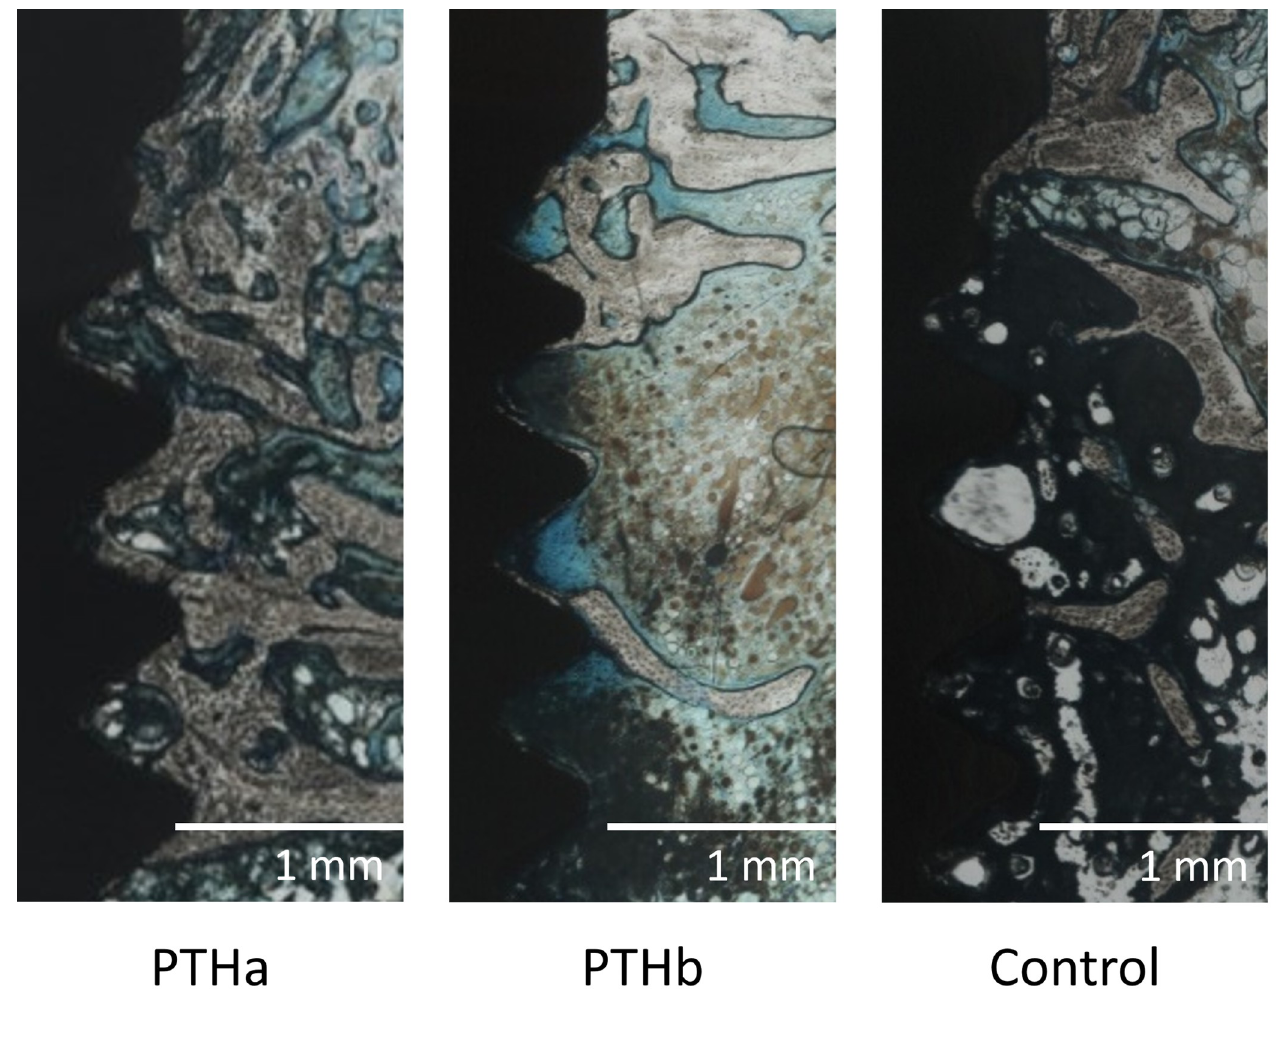
Fig 6. Histological observation. In the PTHa group, new trabecular bone formation and bone-implant contact were detected around the implant threads. The PTHb and Control group samples were mostly comprised of connective tissue and bone marrow tissue. Bone-implant contact was partly